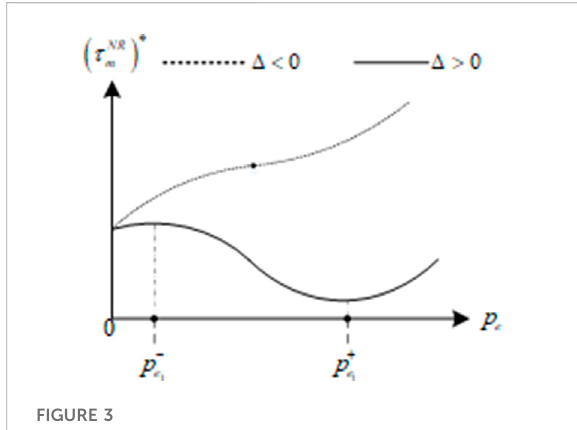
FIGURE 3 Emissions reduction level under strategy